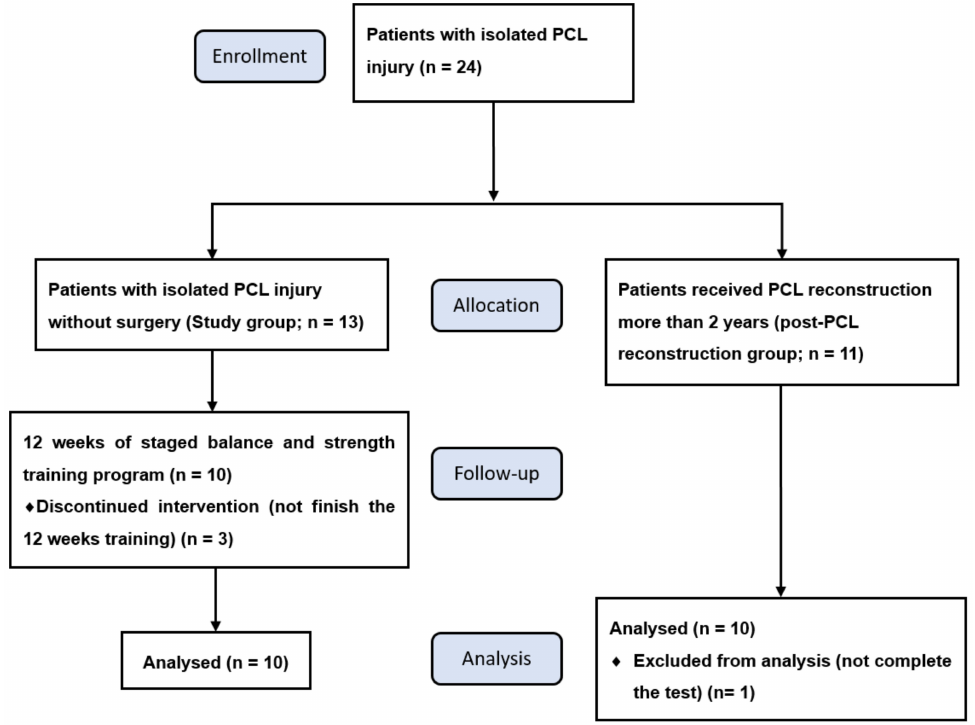
Figure 3. Flowchart of participant selection, follow-up and analysis. PCL, posterior cruciate ligament.